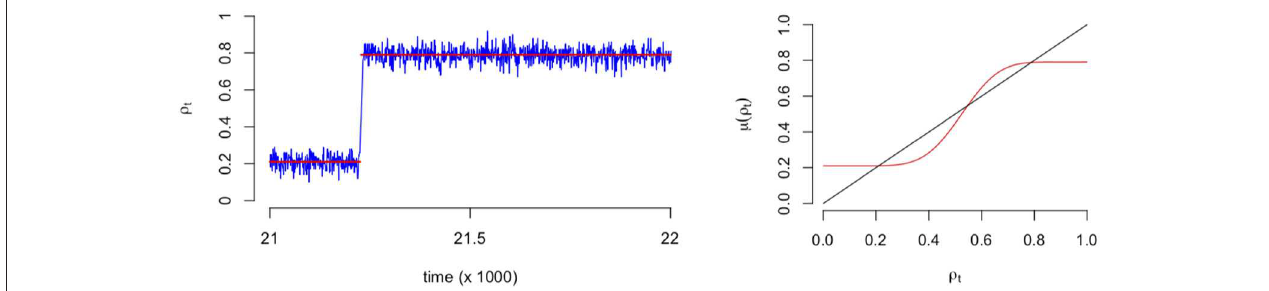
FIGURE 3 | Example of a stochastic cellular automata process that includes a transition (Left) . Example of the corresponding expectation of mean field function (Right) . The red line indicates the expectation of Equation (3) divided by the number of